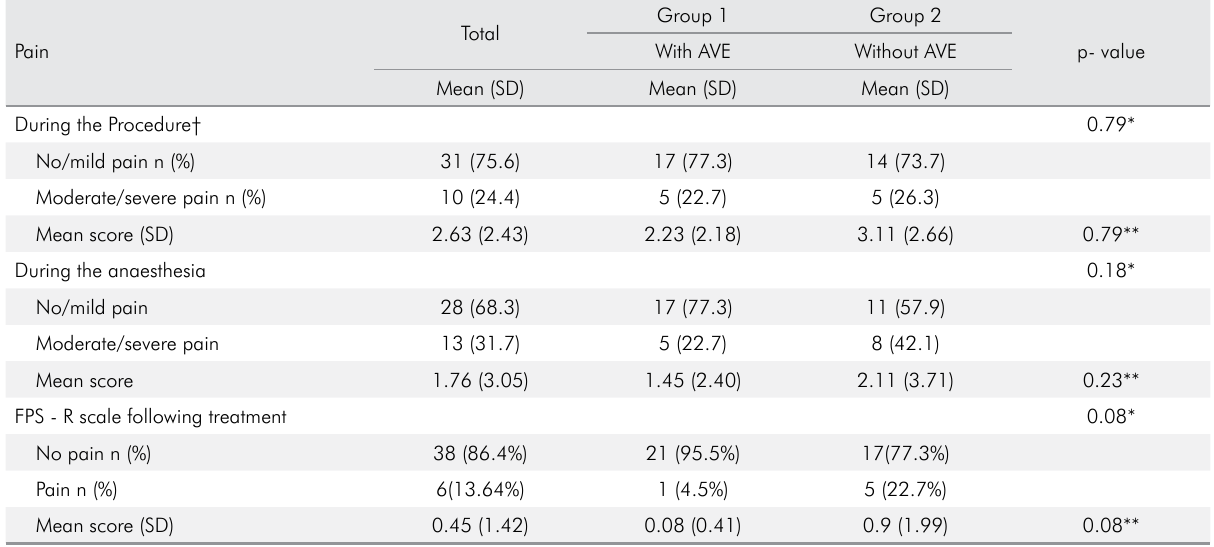
Table 4. Pain perception evaluated using the Face, Legs, Activity, Cry and Consolability (FLACC) scale during the visit and following the procedure using the Faces Pain Scale revised (FPS-R) according to the use of audiovisual eyeglasses (AVE) (n =